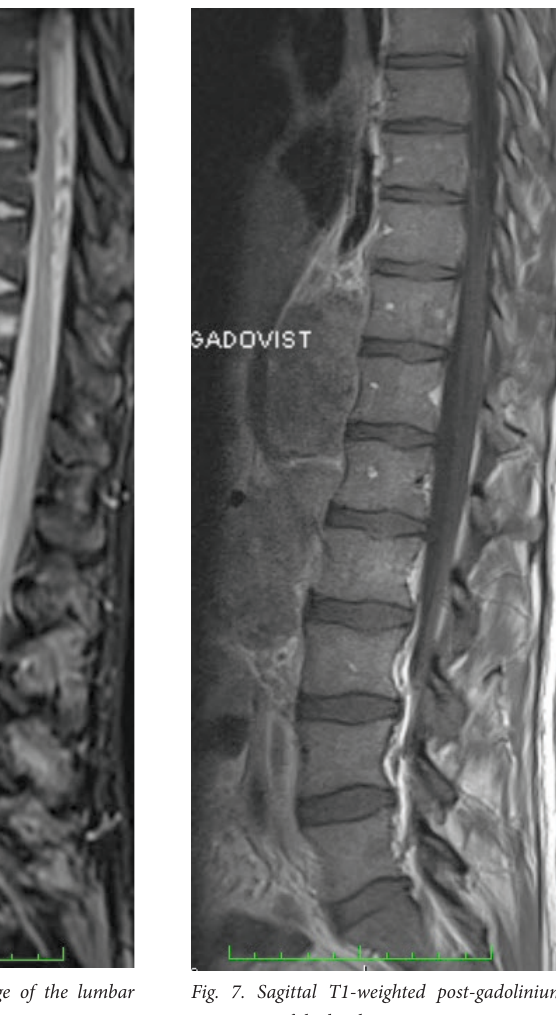
Fig. 7. Sagittal T1-weighted post-gadolinium MR image of the lumbar